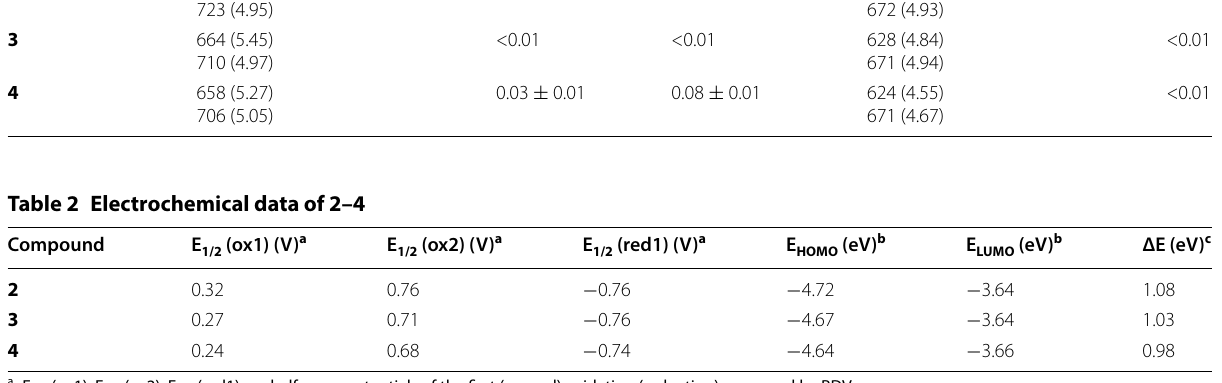
a E 1/2 (ox1), E 1/2 (ox2), E 1/2 (red1) are half-wave potentials of the first (second) oxidation (reduction) measured by RDV b E HOMO/LUMO = − [E 1/2 (ox1/red1) + 4.4] eV. All potentials are given vs. SCE c